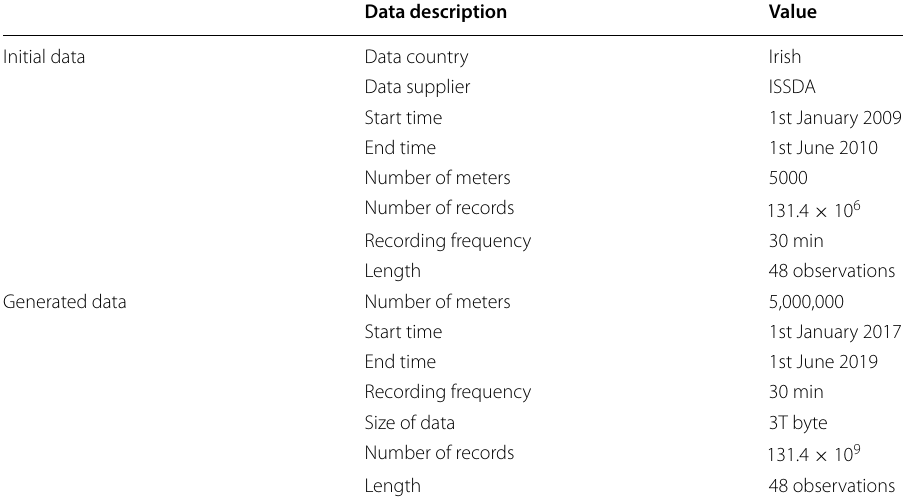
Table 1 Initial and generated data description